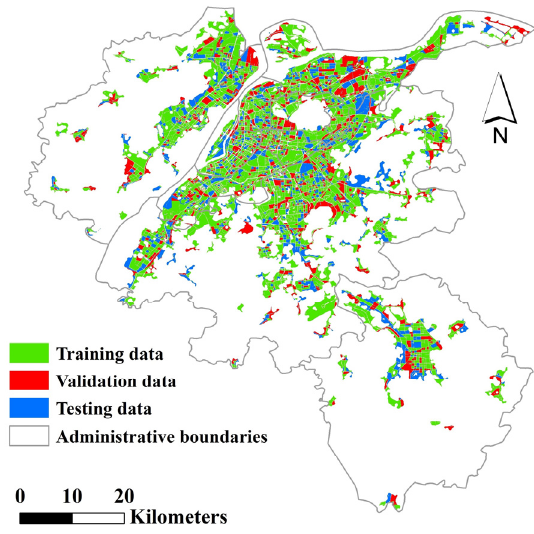
Figure 7. Distribution of training set, validation set, and testing set.